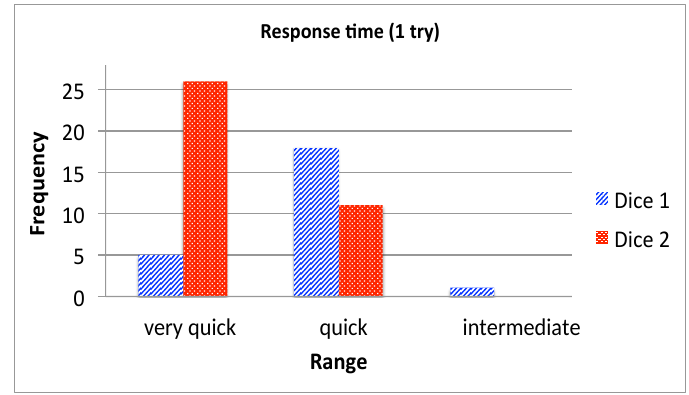
Figure 6. Distribution of the discretized solution time in Dice 1 and 2